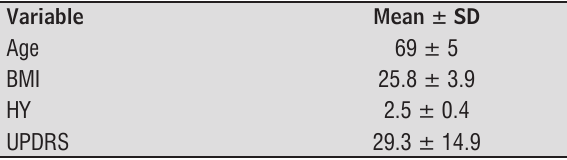
Table 1 - Epidemiological and clinical characteristics of elderly with PD attended at CREASI in Salvador/BA, 2016